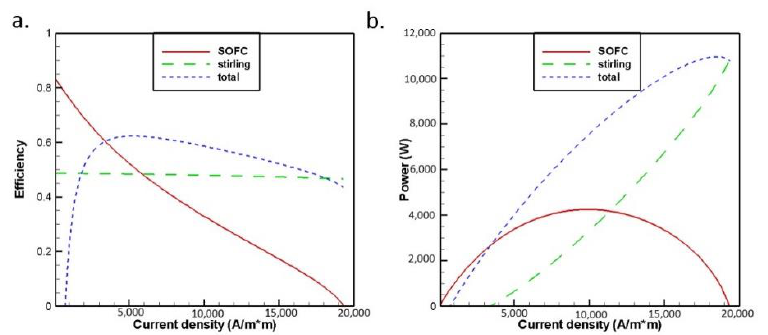
Figure 4. Computed ( a ) efficiency, and ( b ) generated power for different current densities at 873 K for hybrid SOFC-SE system without heat components (Emin [20]).